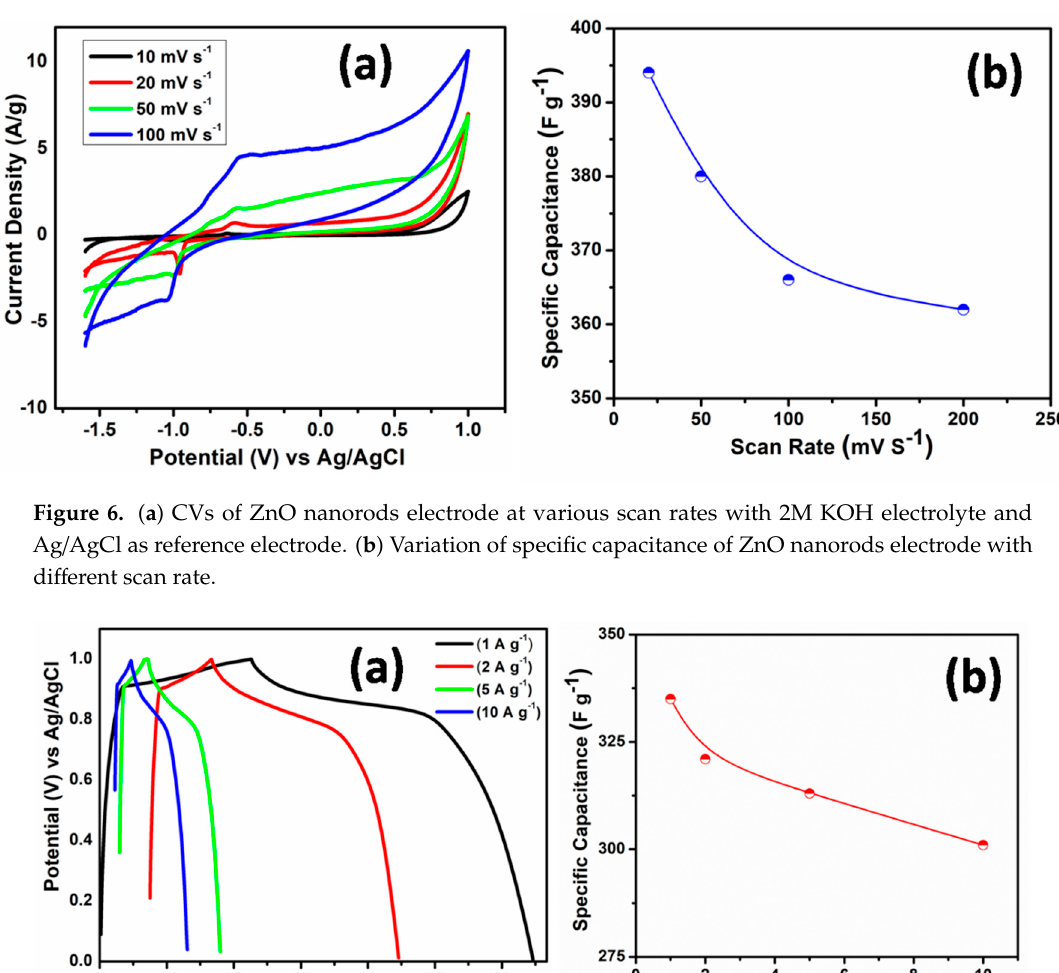
Figure 6. ( a ) CVs of ZnO nanorods electrode at various scan rates with 2M KOH electrolyte and Ag/AgCl as reference electrode. ( b ) Variation of specific capacitance of ZnO nanorods electrode with different scan rate.